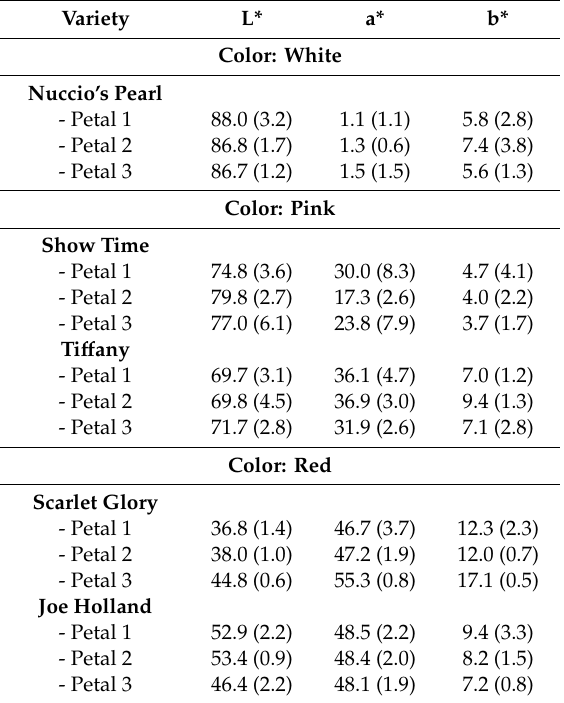
Table 6. Mean (standard deviation) of one Nix TM Pro color sensor’s readings from three locations within each of three sampled petals from the same camellia